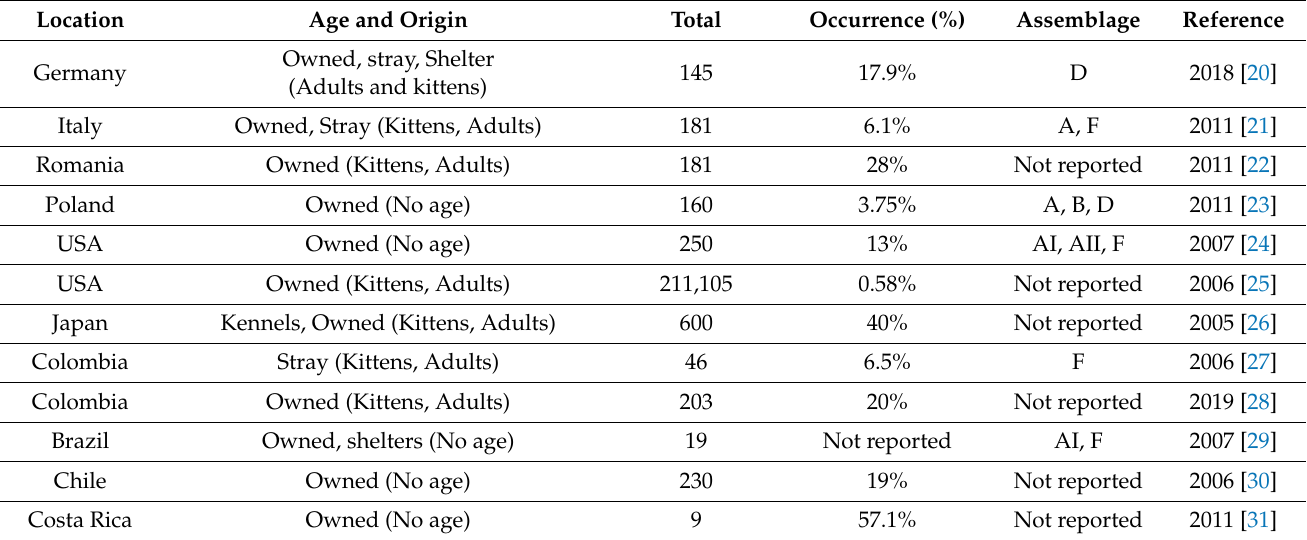
Table 1. Occurrence, origin, age, and assemblages of Giardia duodenalis in